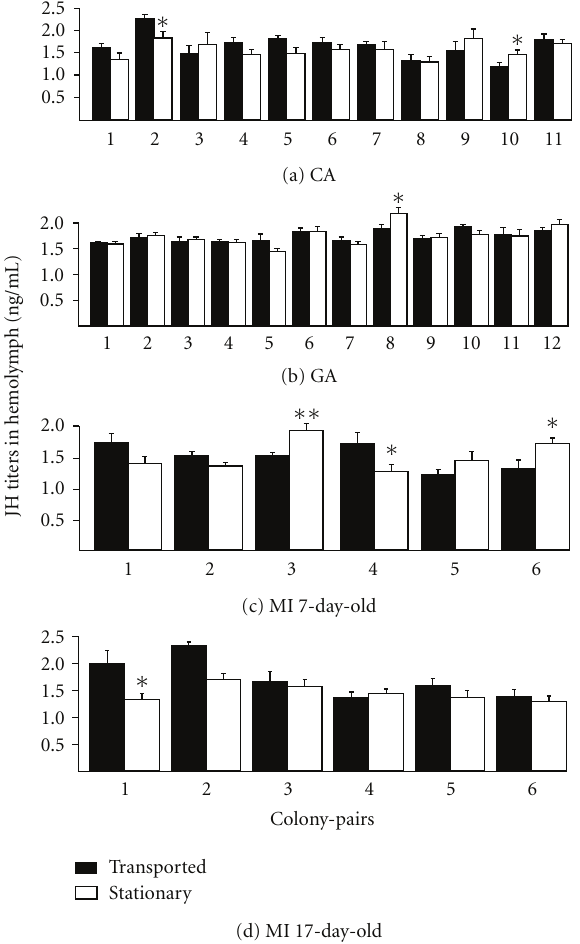
Figure 1: Hemolymph juvenile hormone titers (mean ± SE) in worker honey bees experiencing transportation (solid) or no transportation (open) in California (a), Georgia (b), or Michigan ((c), (d)). Workers were 6-7 days old for CA, 8 days for GA and noted in figure for MI. N = 10 bees for each colony. Each number represents a colony-pair that hosted genetically similar workers from a source colony. A ∗ inside the open bar indicates that the JH titers between the two colonies within that colony-pair were significantly di ff erent ( t -test, P < 0.05), while ∗∗ denotes highly significant ( P <